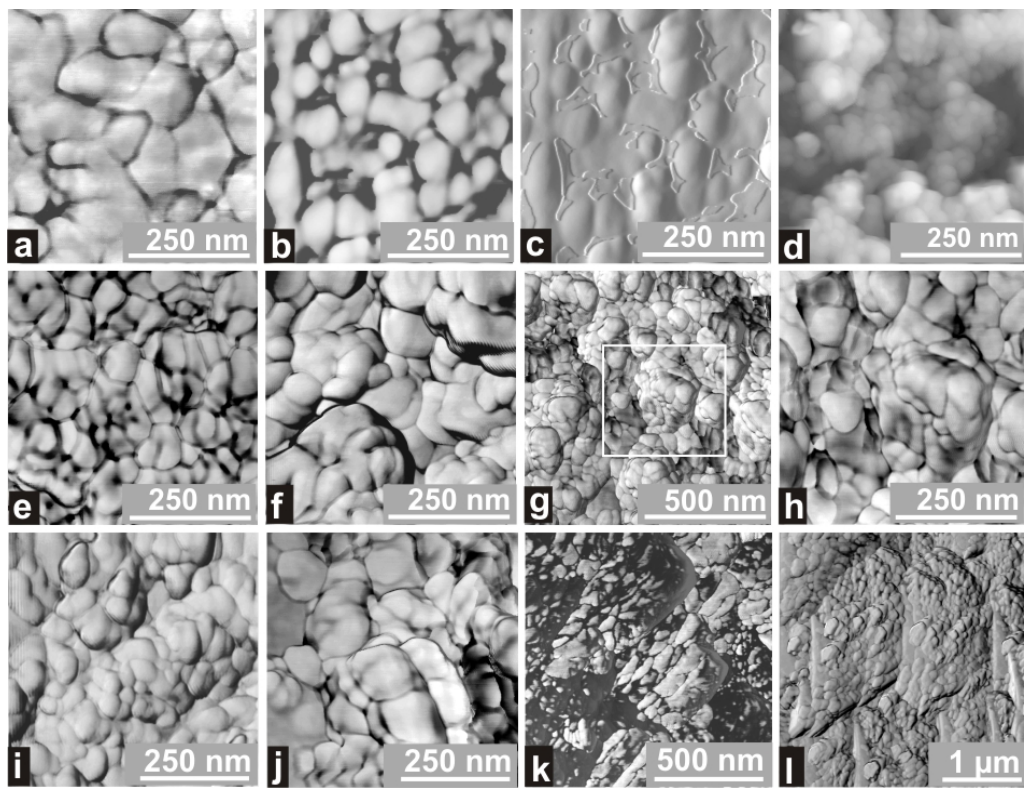
Figure 6. Uniformity of the reticulate pattern in mollusks and coral skeletons at comparable enlargements. ( a ) Calcite prisms of Pinctada ; ( b , c ) Aragonite from the nacreous layer: phase-lag mapping ( b ) and same surface viewed in amplitude mode, an AFM tapping mode that emphasizes the changes in surface slopes; ( d ) nacre of a Pinctada pearl. This signal is the direct expression of surface topography. The spheroidal surfaces of the skeletal units are clearly visible. High resolution SEM pictures are now able to provide equivalent data; ( e ) Aragonite of a Scleractinia coral skeleton ( Favia ); ( f ) Organ-pipe coral ( Tubipora ), a calcitic Alcyonaria; ( g , h ) The white coral ( Corallium johnsoni ): another calcitic Alcyionaria; ( i ) The blue coral ( Heliopora coerulea ), the only aragonitic Alcyonaria; ( j – l ) The red coral ( Corallium rubrum ). This species remarkably exemplifies the post-depositional evolution of the organo-mineral material of the skeleton, leading to formation of wider units ( j , k ), whose spatial arrangement are irrespective of the layered growth